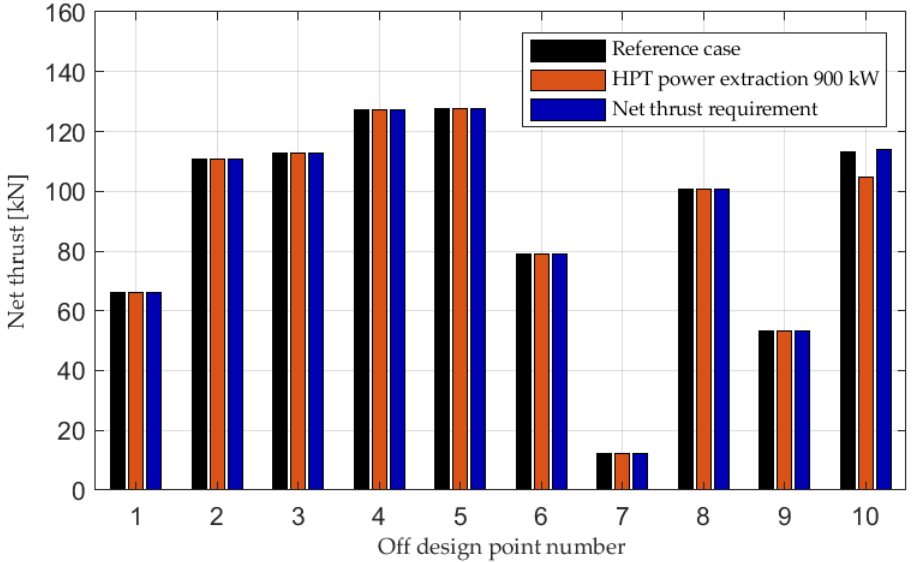
Figure 4. Net thrust with and without HPT power extraction.